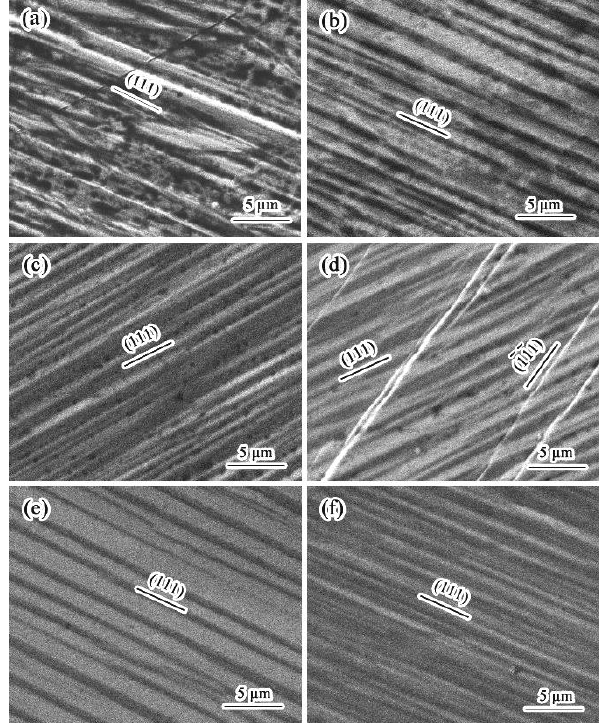
Figure 2. SEM images of the surface deformation features of unfatigued or pre-fatigued [ 233 ] Cu single crystals under uniaxial tension: ( a ) unfatigued; ( b – f ) pre-fatigued at γ pl = 1.3 × 10 − 4 , 3.4 × 10 − 4 , 9.2 × 10 − 4 , 3.5 × 10 − 3 , and 5.3 × 10 − 3 , respectively. ( a , b , e , f ) viewed from ( 6 9 13 ) ; and ( c , d ) viewed from ( 6 9 13 ) . Note that the loading direction is